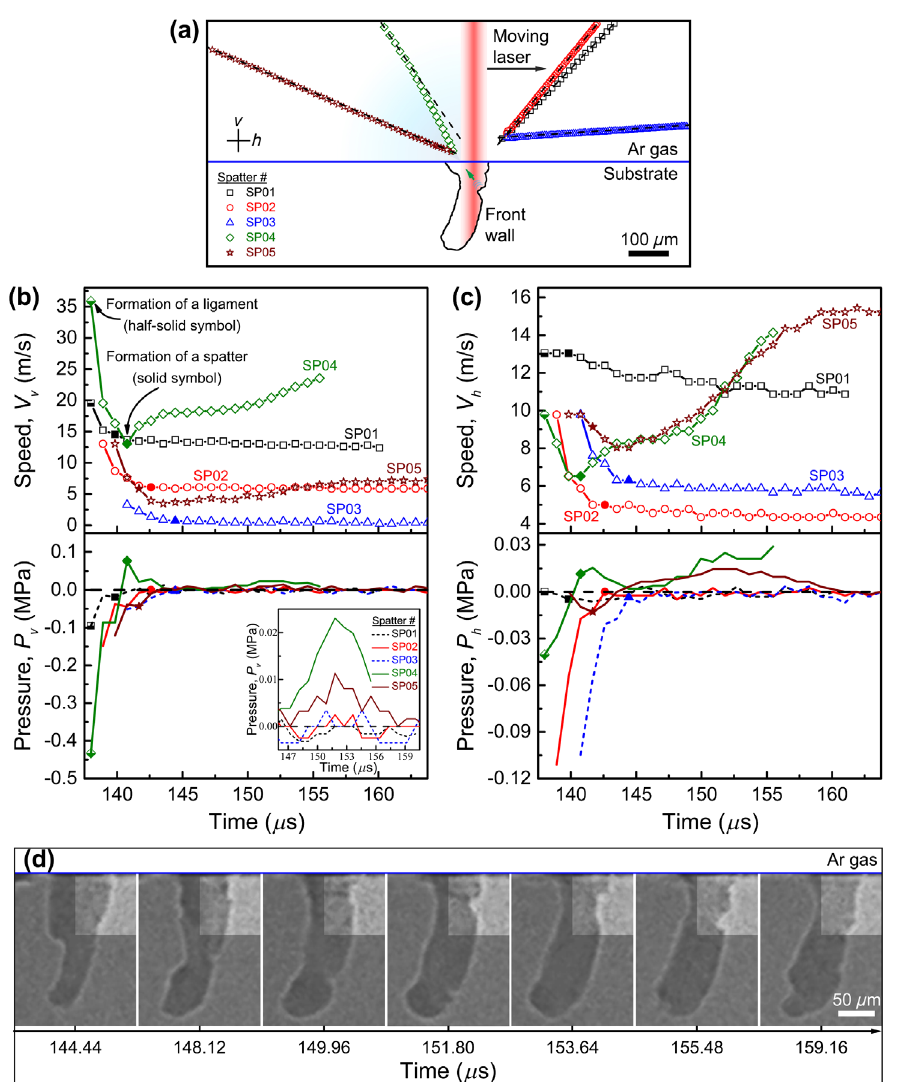
FIG. 3. Spatter behaviors and pressure field. (a) Trajectories of five ejected particles in one spattering process. SP01 – SP03 are forward-flying spatters, and SP04 and SP05 are backward-flying spatters. The reference black dashed lines highlight the curved trajectories of the spatters SP04 and SP05. The diffused sky blue background on the left side of the laser indicates the vapor plume zone arising from the front wall of the keyhole. (b),(c) Vertical and horizontal travel speeds (upper panels) and the calculated pressures on melt ligaments and spatters (lower panels). The half-solid symbols in each plot indicate the times when the thin melt ligaments appear. The solid symbols mark the times when spatters separate from the melt pool. The negative pressure represents a net force that slows down the motion of the liquid structure, while the positive pressure accelerates the objects. The inset of (b) is a closer look at the vertical pressure field the spatters experience. (d) X-ray images of the keyhole morphology. The top region of the front keyhole wall is highlighted. The protrusion appearing between 149.96 and 155 . 48 μ s increases the local laser absorption, creating a stronger vapor plume that is responsible for the increased pressures on spatters SP04 and SP05. All images shown here are background corrected using the images collected before the laser melting. The contrast is then reversed to highlight the keyhole